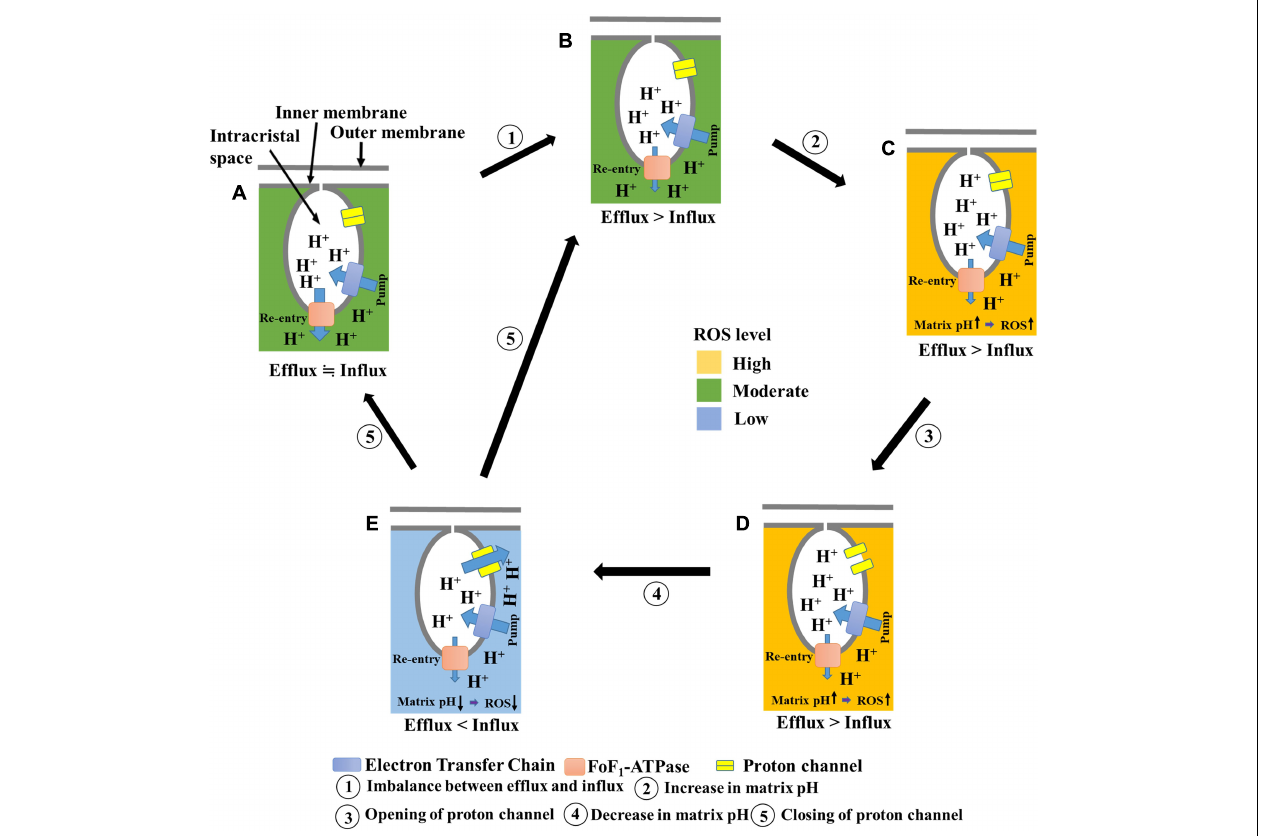
FIGURE 7 | Schematic illustration of the proposed model for transient depolarization and ROS production. (A) Healthy mitochondria show proton efflux and influx equilibrium. ROS are moderately produced. (B) Influx of protons is suppressed. (C) Suppression of proton influx results in increased matrix pH. At this state, ROS production is enhanced. (D) The elevated matrix pH induces the opening of a proton channel. (E) Proton influx through the channel decreases pH. At this state, the level of ROS production is low. The proton channel is closed after the decrease in matrix